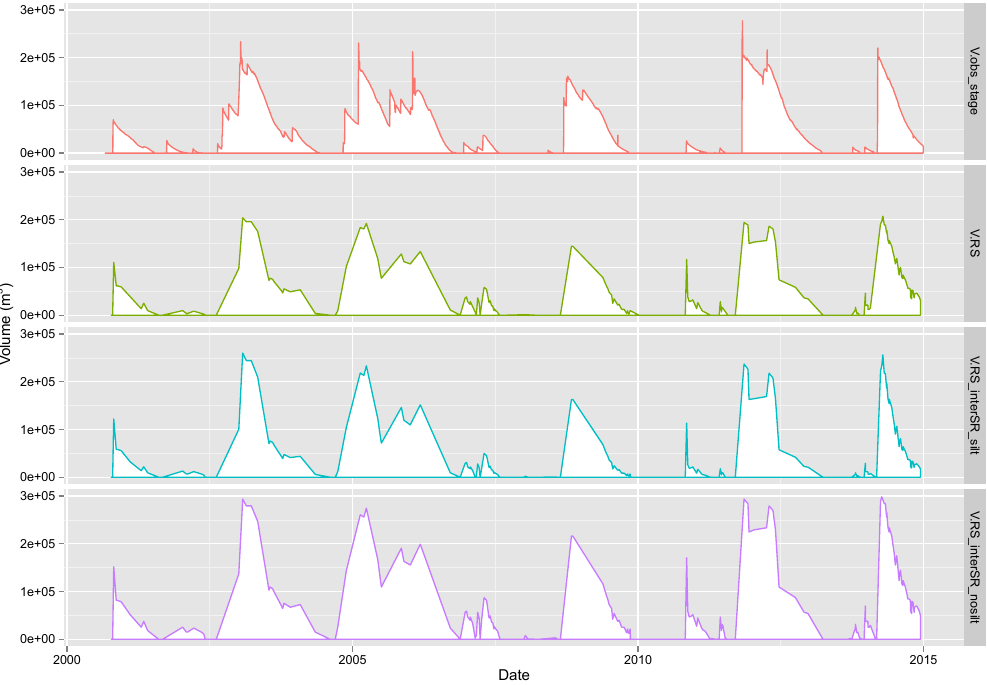
Figure 11. Daily volumes for Gouazine lake over 2000–2014 based on: (i) observed stage data; (ii) Landsat data using a site-specific rating curve; (iii) Landsat data using the power relation adapted for silting; (iv) Landsat data using the power relation not adapted for